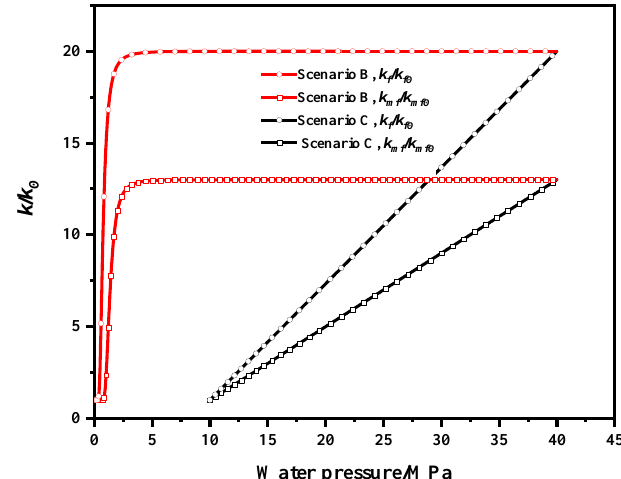
Figure 11. Intrinsic permeability variations with injection pressure.